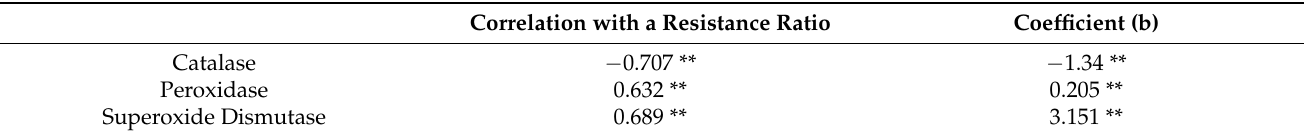
Table 4. Correlation and regression of resistance ratio vis-à-vis antioxidant enzymes in different field populations of Rhyzopertha dominica .